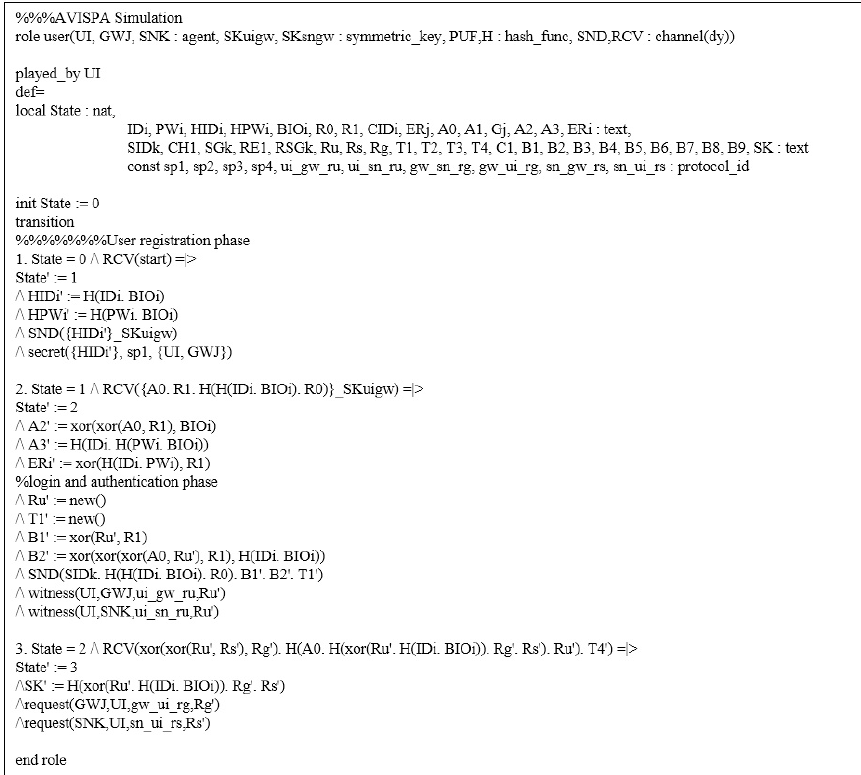
Figure 10. Role specification for the user.